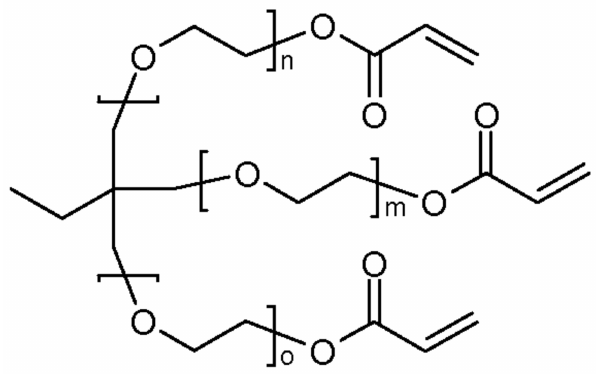
Figure 1. Structure of trimethylolpropane triacrylate (TMPTA) and ethoxylated TMPTA (EO6TMPTA): ( a ) TMPTA: n + m + o = 0; and ( b ) EO6TMPTA: n + m + o =